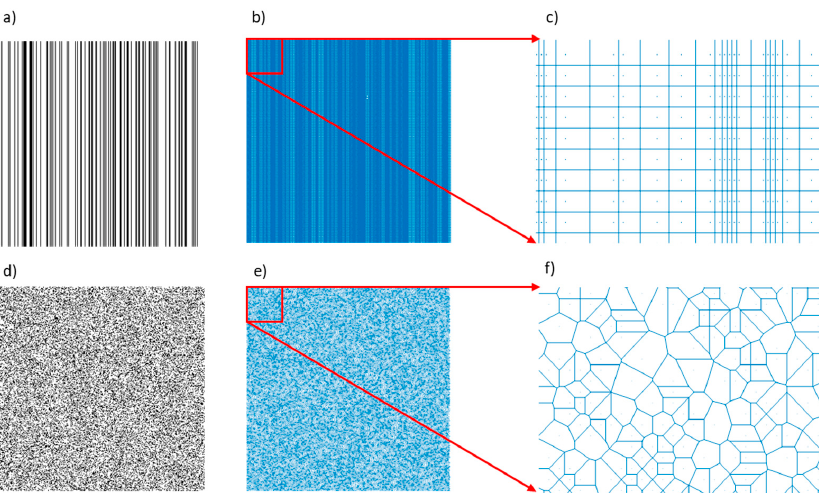
Figure 2. Topological entropy ( TS ) for different planes: ( a ) microstructure with aligned bars; ( b ) microstructure characterized by Voronoi diagrams with TS = 0; ( c ) zoomed section of the characterized microstructure to observe the order of the phases; ( d ) randomly agitated microstructure; ( e ) microstructure characterized by Voronoi diagrams with a TS = 0.18; ( f ) zoomed section of the characterized microstructure, which shows a polygons deformation.